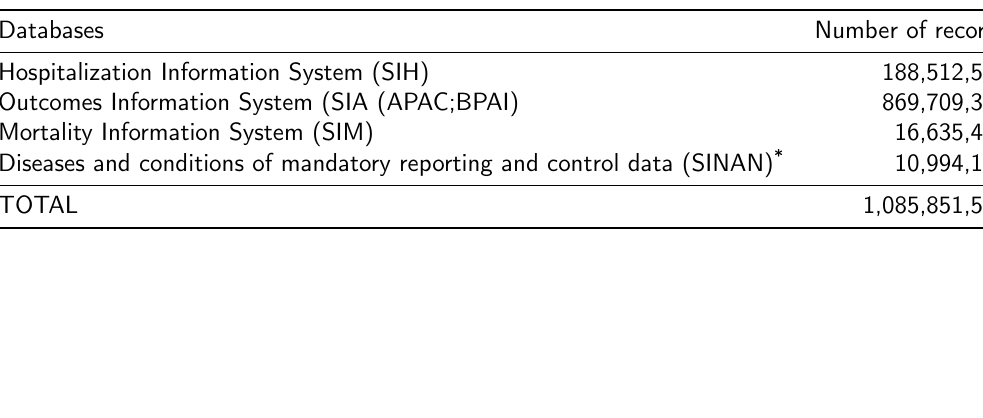
Table 1: Databases received from the Ministry of Health in the period of 2000-2015